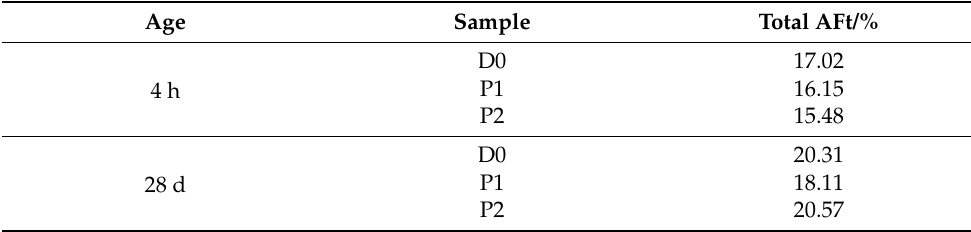
Figure 11. DSC curves of composite cement in N 2 atmosphere.